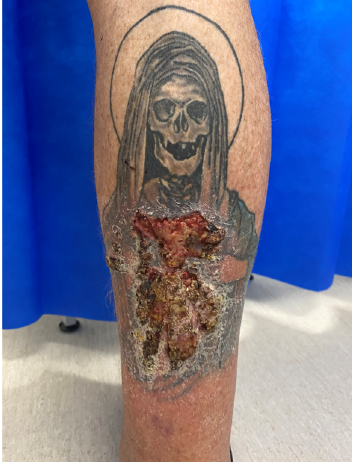
Figure 6. Macroscopic appearance after deep shave biopsy was performed.